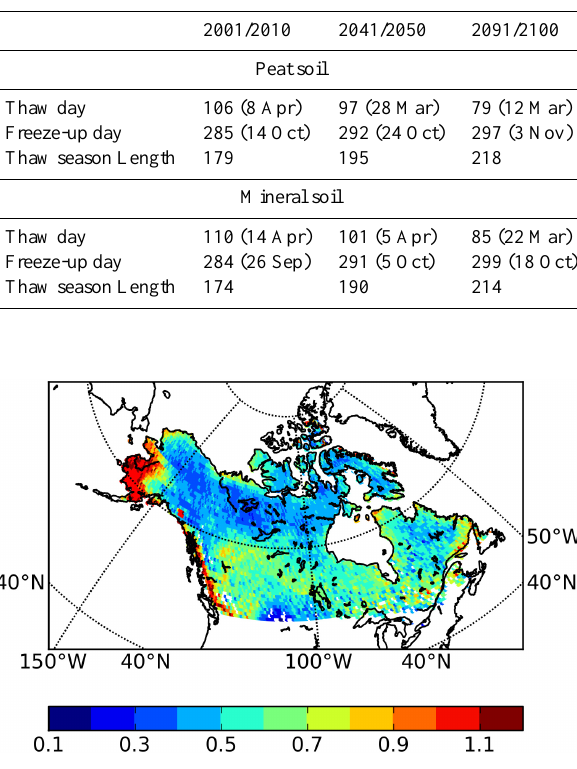
Table 2. Domain mean annual start dates, end dates (Julian Day and date) and length (days) of the frost-free period in peatlands and mineral soils for first, mid, and last decades of 21st century.